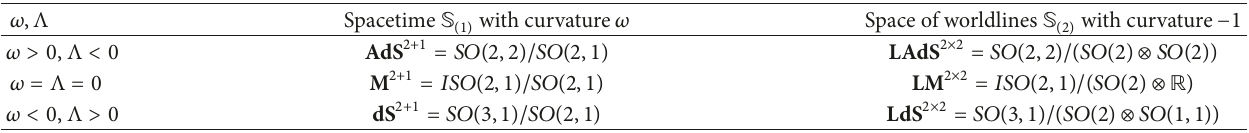
(2) with curvature